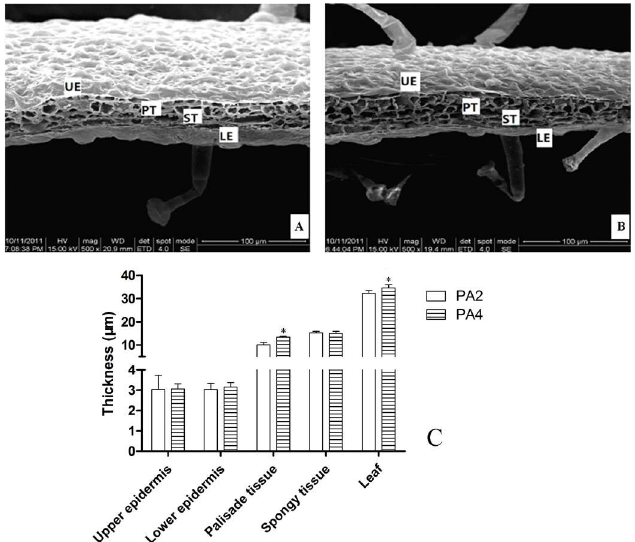
Fig 2. Leaf microstructure of PA2 and PA4. (A) leaf microstructure of PA2 (B) leaf microstructure of PA4 (C) measurents of leaf microstructure. UE, upper epidermal. LE, lower epidermal. PT, palisadetissues.ST, spongy tissues. Bar = 100 μ m. The cell numbers in PA2 and PA4 are 176 ± 8and 140 ± 5,respectively. The cell sizes (mean area) of PA2 and PA4 are 32.60 ± 2.04um 2 37.21 ± 2.04um 2 . Error bars represent the standard error of the mean. * : Statistically significantdifferences betweenPA2 and PA4 ( P < 0.05).